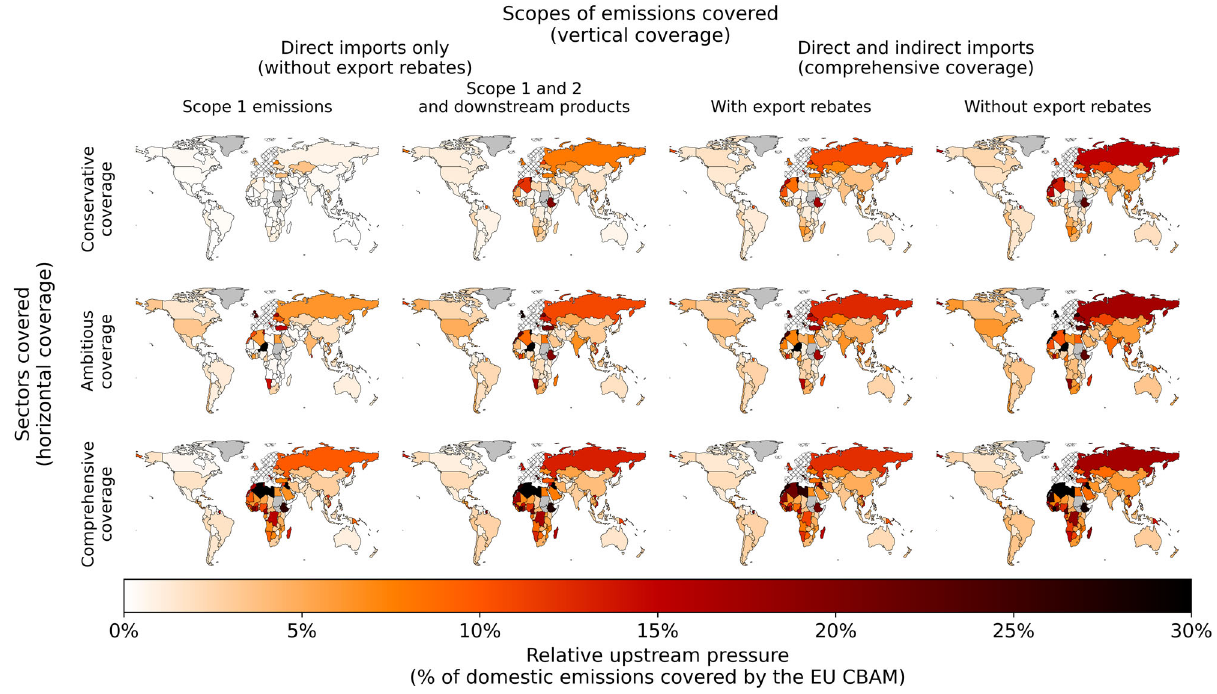
Fig. 5 Distribution of the relative upstream pressure under different EU CBAM implementations. Coloring shows the share of domestic emissions of each country covered by the EU CBAM implemented. Rows indicate the types of emissions covered by the EU CBAM (see Fig. 1). Columns correspond to the scope of emissions being covered by the EU CBAM (see Fig. 1). The numerator of the relative upstream pressure corresponds to the volume of emissions caused in the corresponding country and priced by the EU CBAM (absolute upstream pressure). The denominator is the domestic volume of emissions in the sectors covered by the EU CBAM. The upper-left panel corresponds to the most conservative estimation of the coverage of the EU CBAM (only direct emissions from a few sectors). The bottom-right panel corresponds to a comprehensive EU CBAM without export rebates, as shown in Fig.